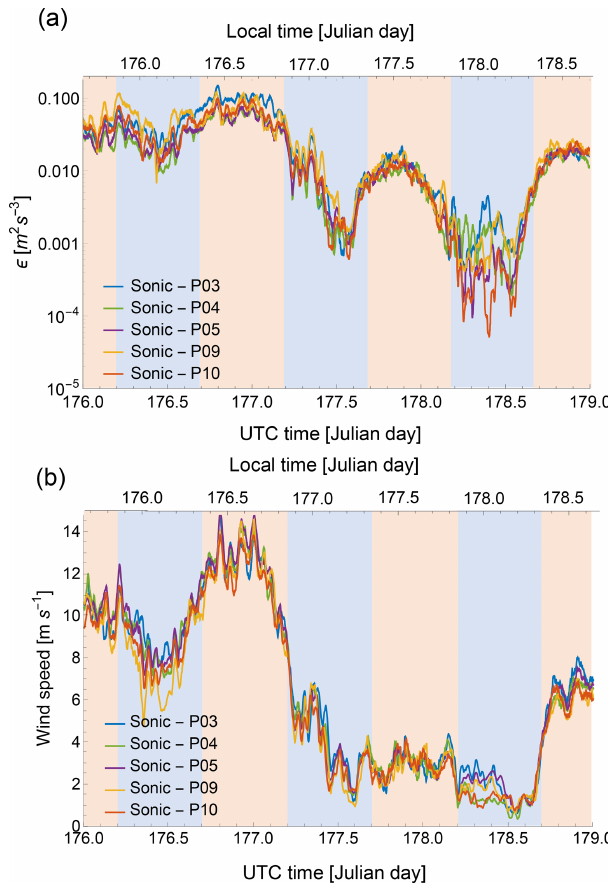
Figure 3. Time series from 24 June 2016 00:00UTC to 27 June 2016 00:00UTC comparing (cid:15) (a) and wind speed (b) from five sonic anemometers at 10ma.g.l. at the Physics Site. Data have been smoothed with a 30min running mean. Blue shaded areas show local nighttime conditions, while orange areas show local day- time